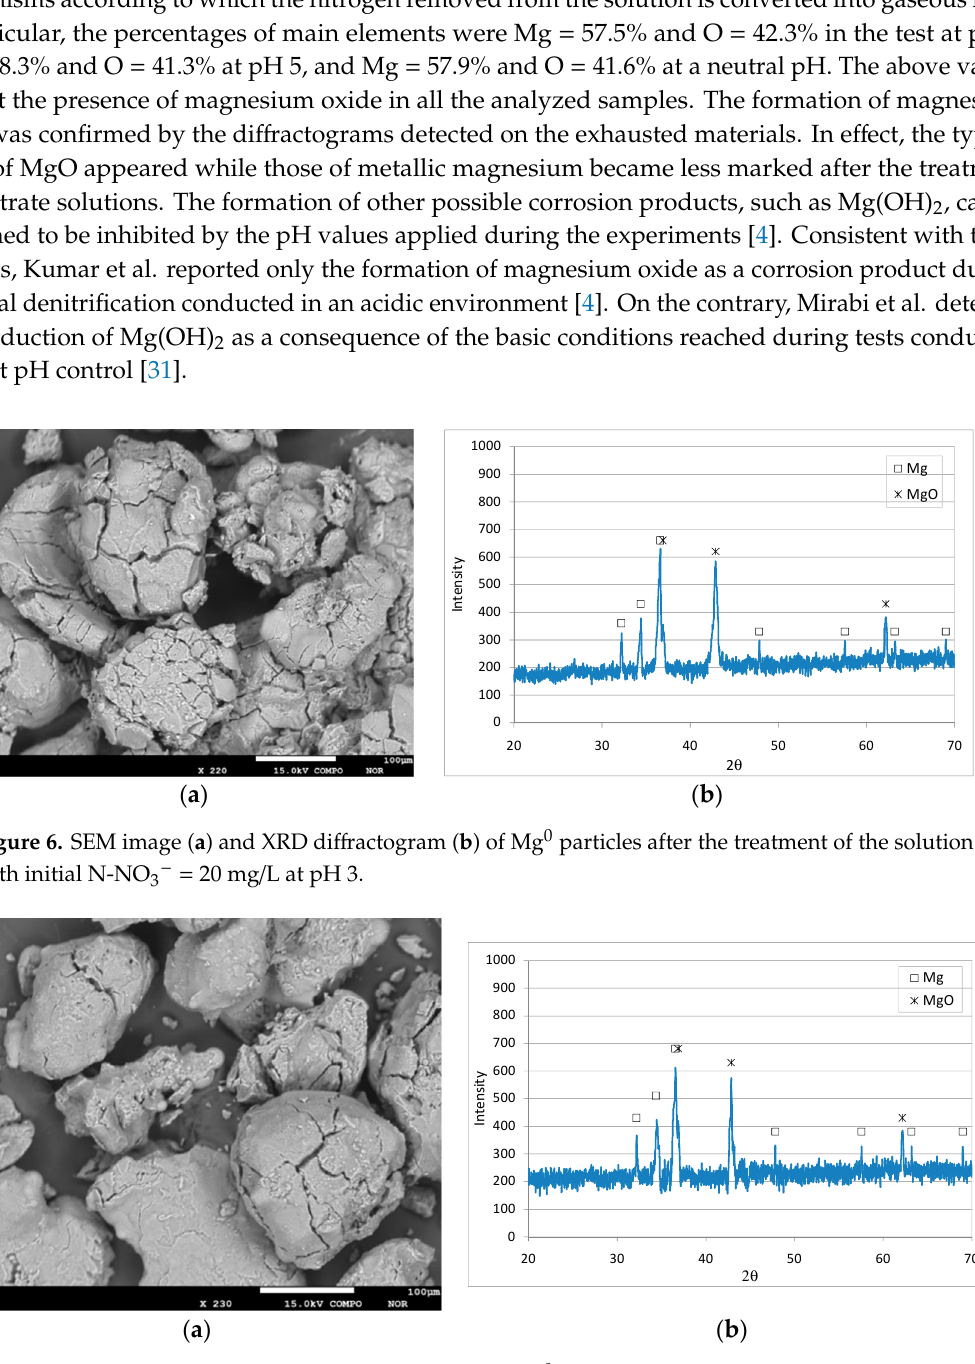
Figure 7. SEM image ( a ) and XRD diffractogram ( b ) of Mg 0 particles after the treatment of the solution with initial N-NO 3 − = 20 mg/L at pH 5.